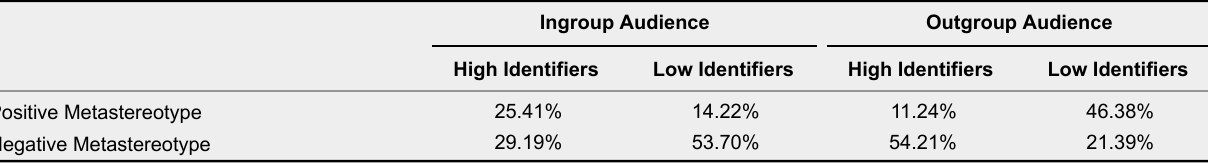
Percentage of Pledges to Help the Outgroup as a Function of Metastereotype Condition, Ingroup Identification, and Audience Group Membership